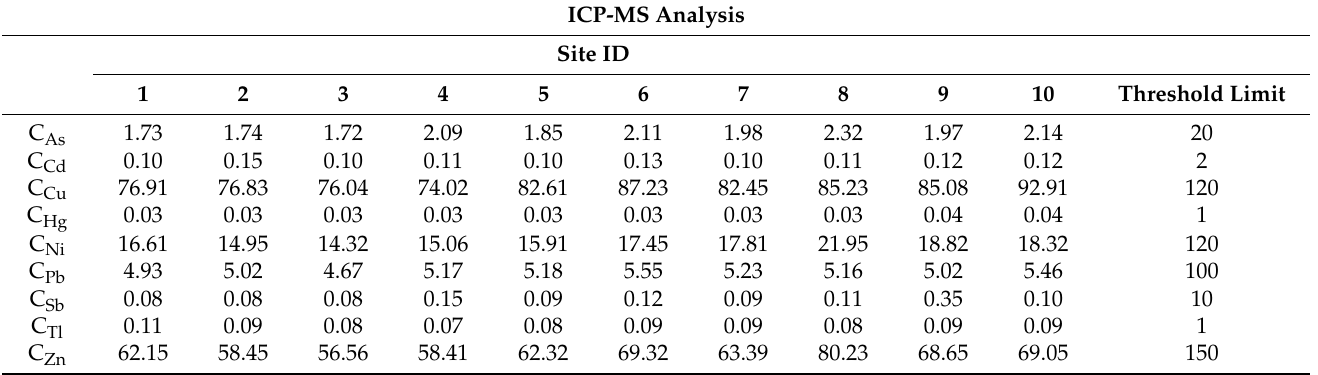
Table 2. Potentially toxic elements content (mg kg − 1 dry weight, d.w.), as obtained through ICP-MS analysis for the analyzed